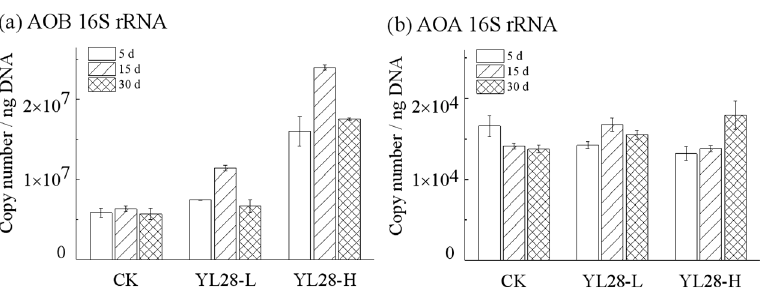
Figure 5. 16S rRNA copy number variation in unit mass DNA (ng). ( a ) Copy number per nanogram DNA of ammonia-oxidizing bacteria (AOB). ( b ) Copy number per nanogram DNA of ammonia-oxidizing archaea (AOA). Initial 16S rRNA copy number of AOB and AOA: (5.13 ± 0.46) × 106, 11 073 ± 321. Significant difference: p < 0.05.